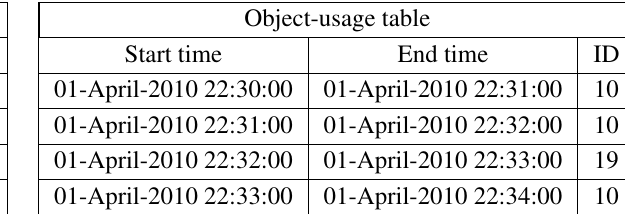
Table 4. An example